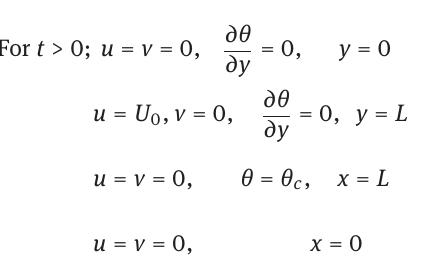
Table 1: Thermophysical properties of water and nanoparticles.